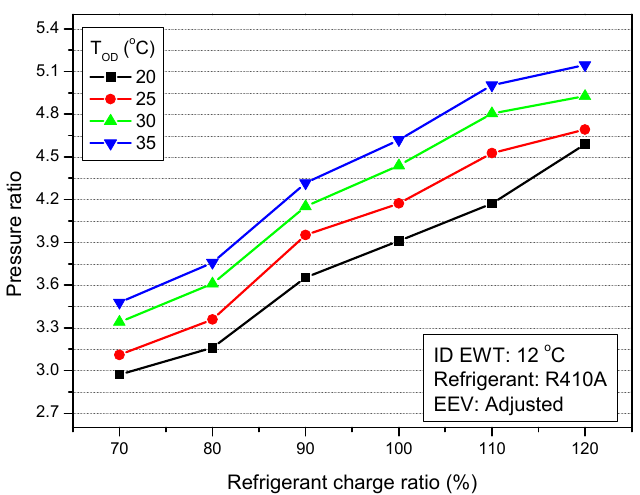
Figure 7. Pressure ratio with variation of refrigerant charge amount and T (cid:2899)(cid:2888) .